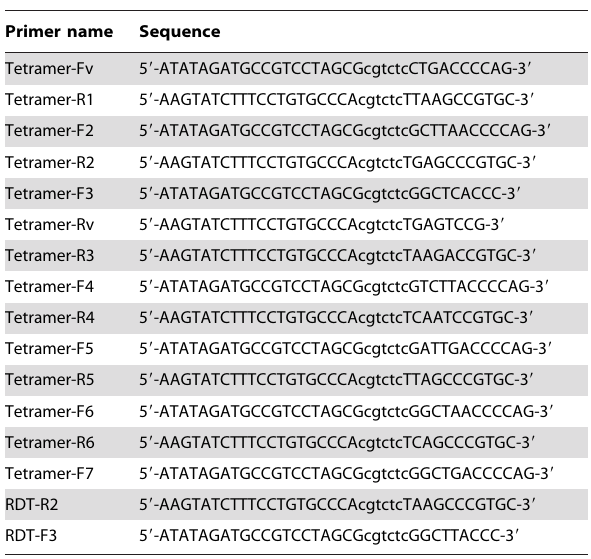
Table 3. Primer sequences for TALE repeats amplification.